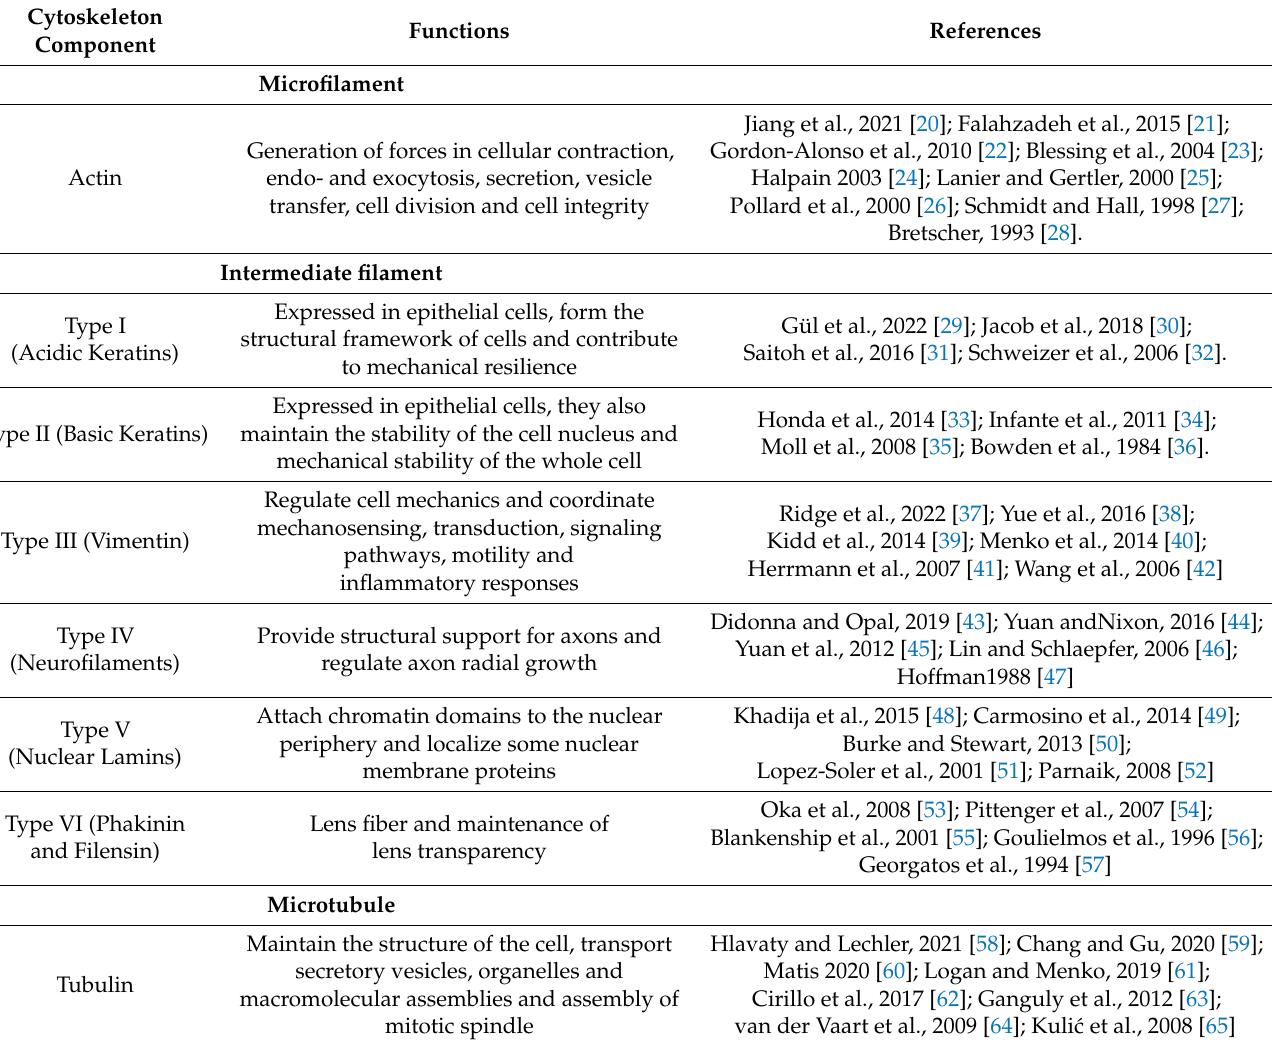
Table 1. Cytoskeleton components and their